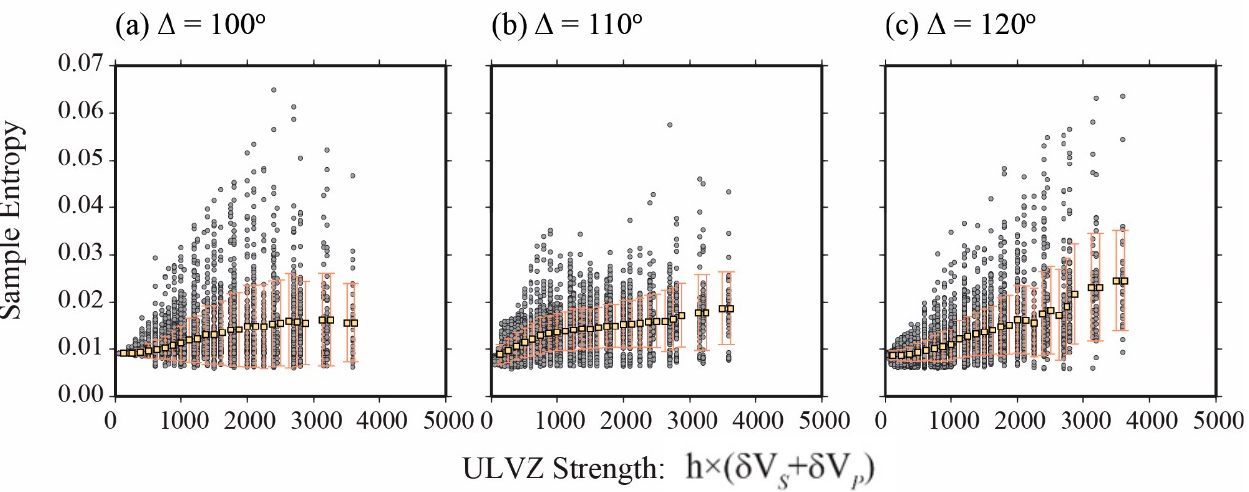
Figure 6. The sample entropy of all 2.5-D ULVZ models are shown at epicentral distances of ( a ) 100°, ( b ) 110°, and ( c ) 120° as a function of ULVZ strength. The individual measurements are shown with gray circles, and the average (yellow squares) and 1– σ range (red bars) are shown in windows of ULVZ strength of 250%·km.